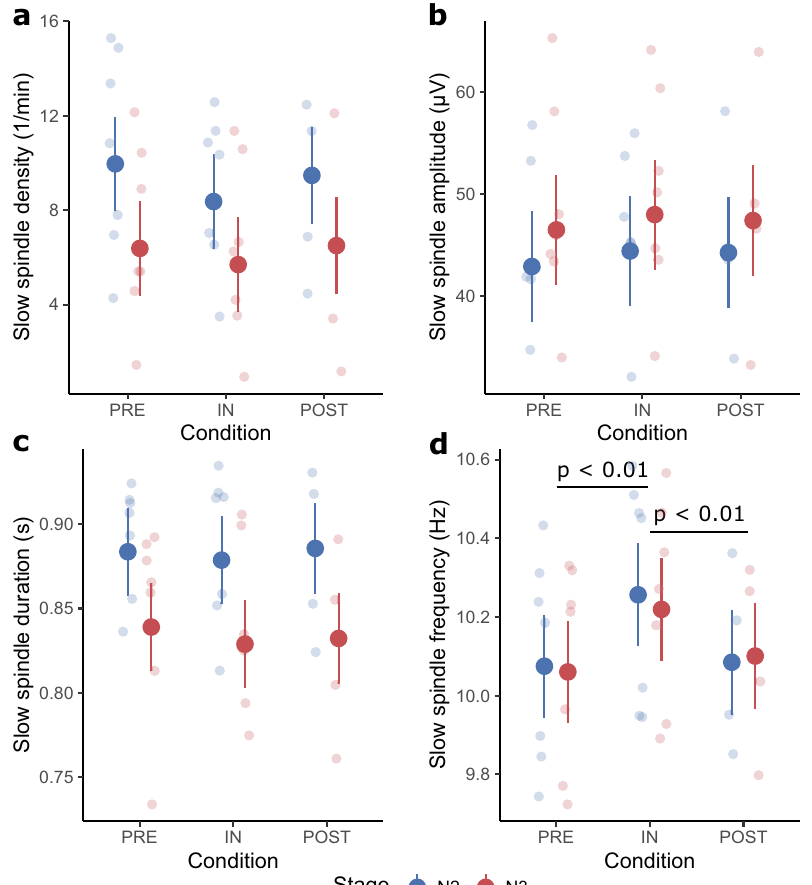
Fig. 3 Slow spindle characteristics. Large dots represent the estimated marginal means (± standard error) of each condition separated by sleep stage. The smaller dots in the background are individual data points in the respective condition and sleep stage. Signi fi cant differences (except between stages) are indicated by a black bar with an annotation stating the p -value. a Shows the slow spindle density. b Shows the slow spindle amplitude. c Shows the slow spindle duration. d Shows the slow spindle frequency with a signi fi cant difference between pre fl ight and in fl ight as well as post fl ight and in fl